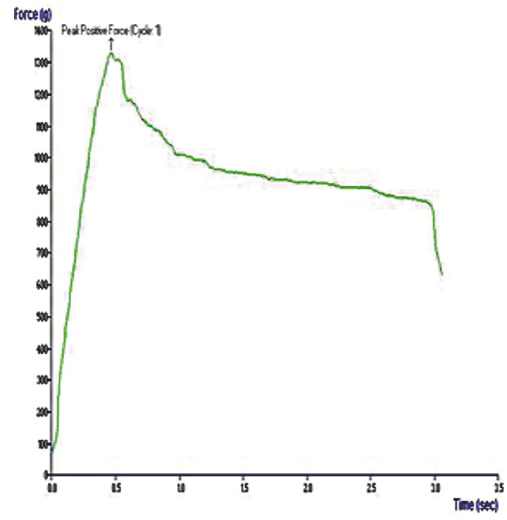
Figure 7: Force versus time graph for fracture strength.